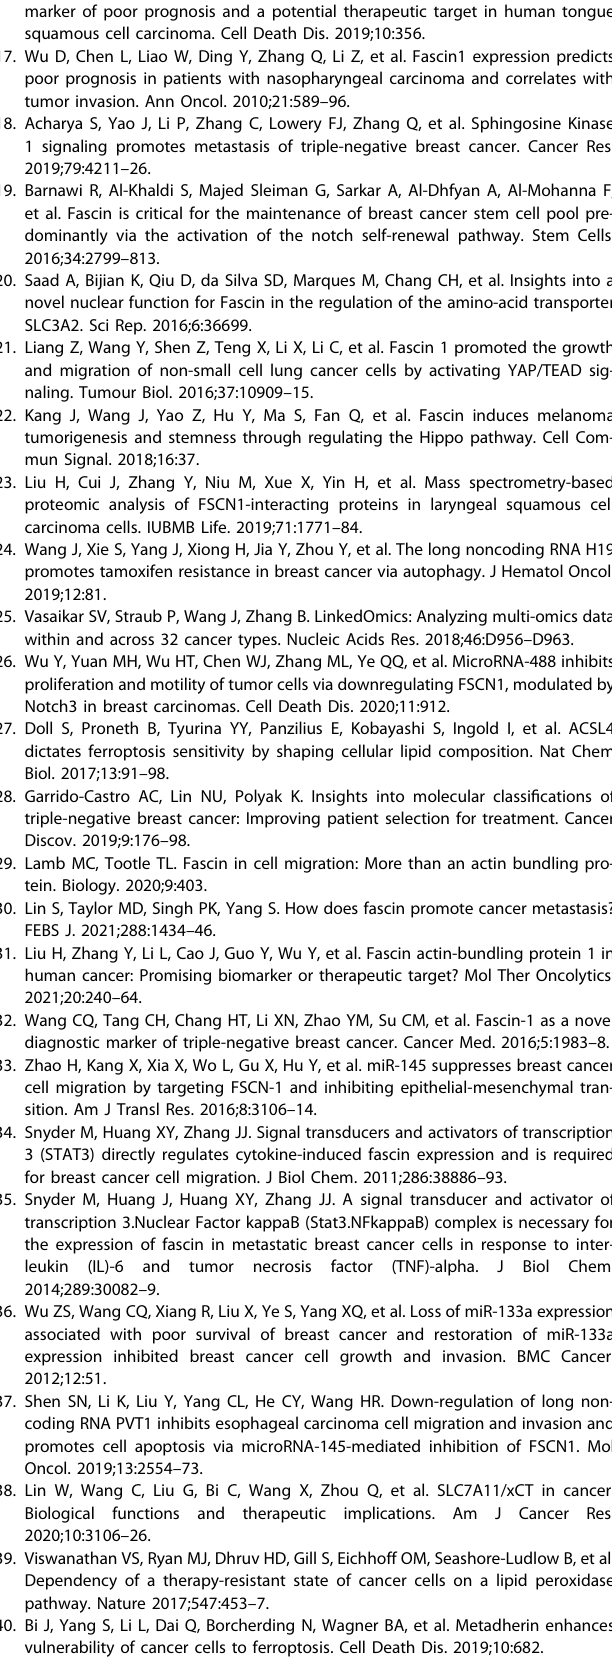
FSCN1 signaling axis prevents the progression of colorectal cancer. Adv Sci.